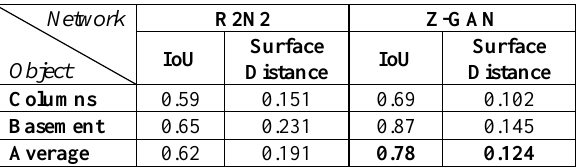
Table 2: The IoU metric and surface distance for R2N2 and Z- GAN networks on two objects from the Cerere temple dataset.